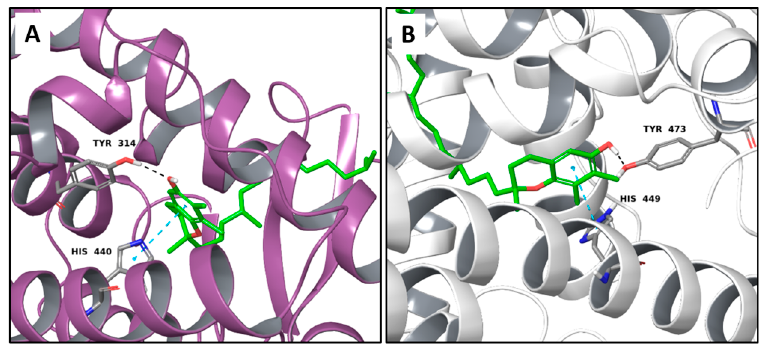
Figure 9. Molecular interactions between O-xylotocopherol and its two best targets involved in the metabolic diseases: ( A ) Protein target PPAR- α (PDB: 3VI8). Protein is shown as a purple cartoon; ( B ) The protein target, PPAR- γ (PDB: 2PRG). Protein is shown as a white cartoon. In both pictures ligand is represented as green carbon sticks. H-bonds and π - π interactions are shown as dashed black and cyan lines respectively. Amino acid residues involved in the interactions are shown as gray sticks.